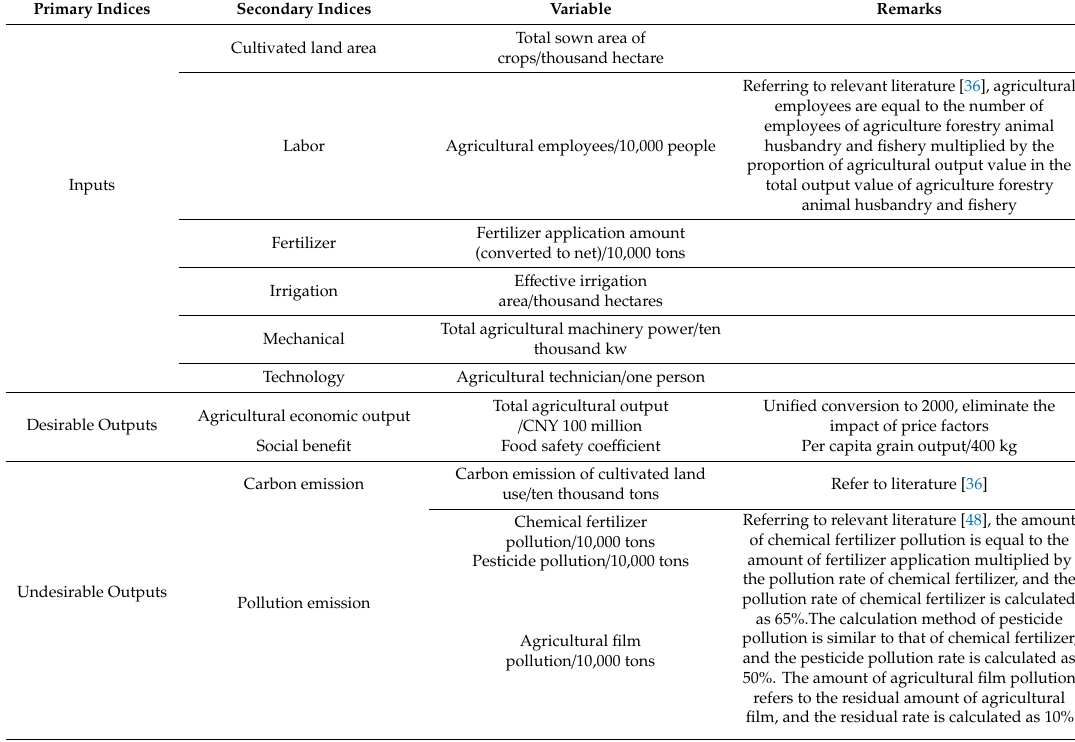
Table 1. Evaluation index system of